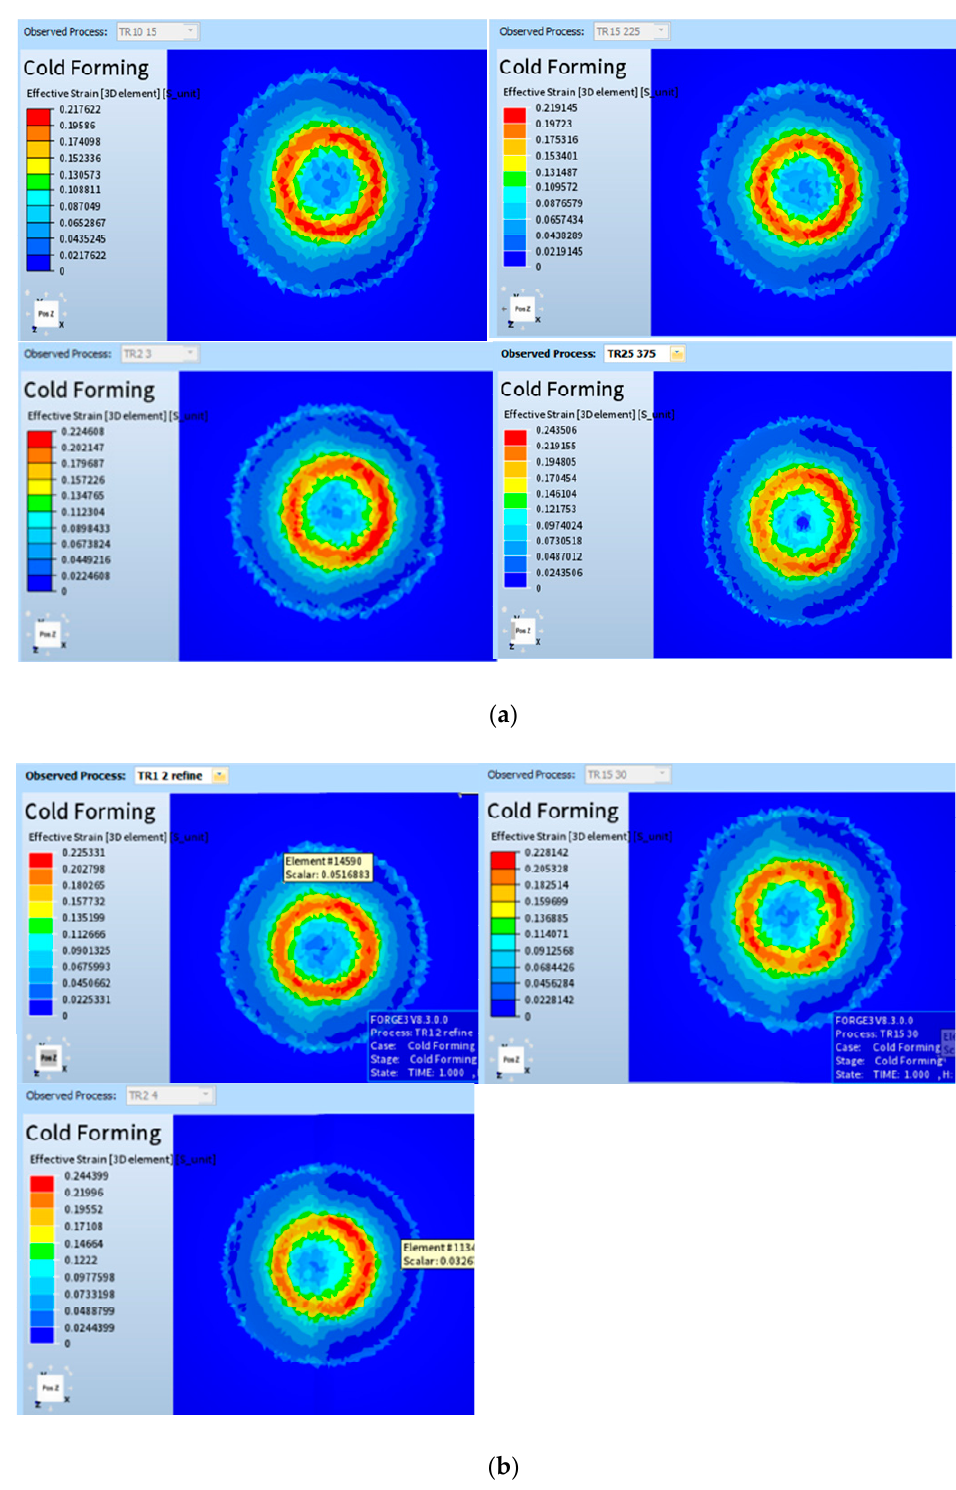
Figure 6. Equivalent plastic strain distribution in the simulations with different thickness ratio: ( a ) thickness Ratio is 1.5:1; ( b ) thickness Ratio is 2:1. ( a ) thickness Ratio is 1.5:1; ( b ) thickness Ratio is